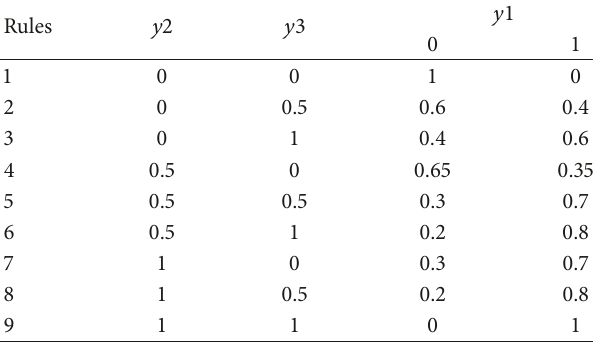
Table 7: The fuzzy gate rules for increased amplitude of the rotor’s power